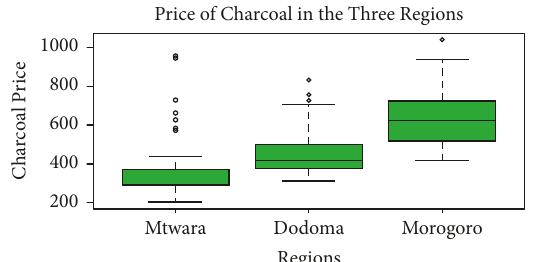
Figure 4: Box-plot of price of charcoal ( y -axis in TZS/kg) in Dodoma, Morogoro, and Mtwara ( x -axis).